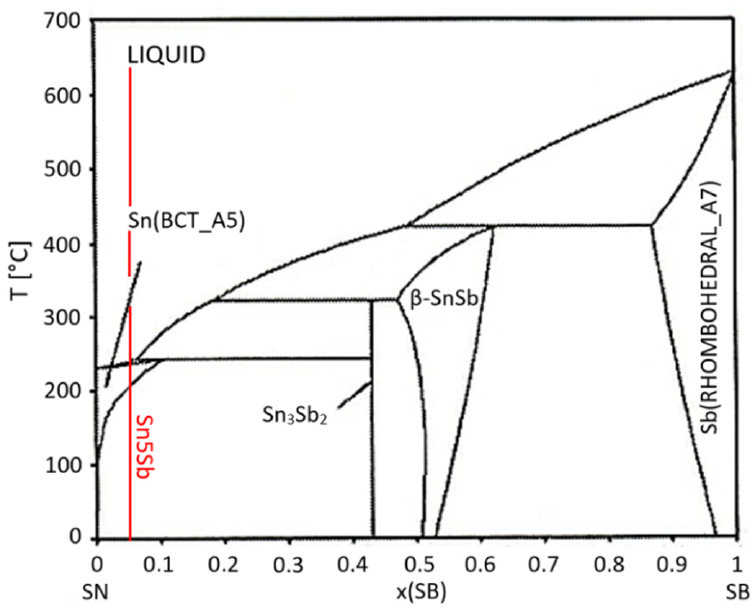
Figure 8. Binary system of tin–antimony [38]. The red line indicates the chemical composition of the Figure 8 . Binary system of tin–antimony [38] . The red line indicates the chemical composition of the Sn5Sb base solder. Sn5Sb base solder .